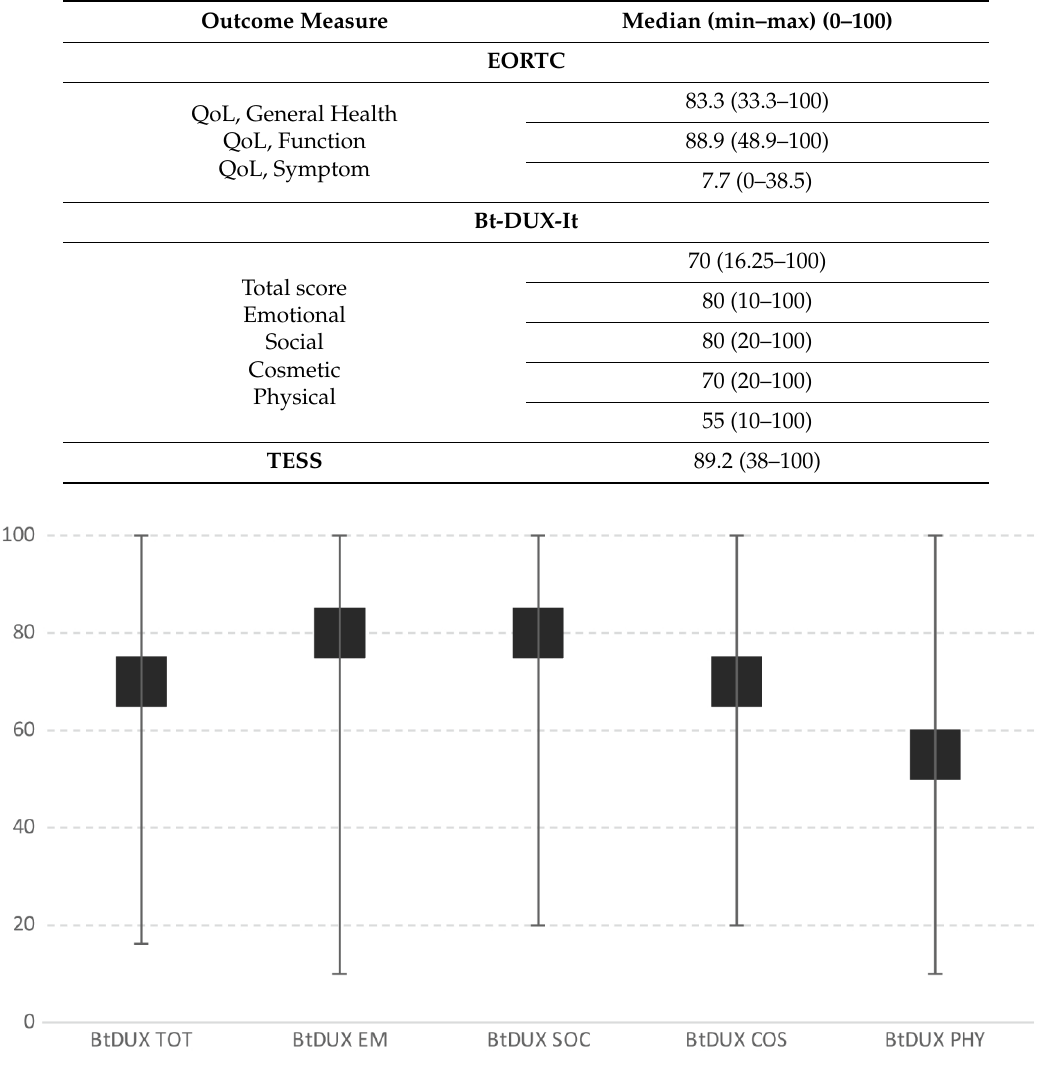
Table 3. Spearman correlation coefficients between the total Bt-DUX-It, Bone tumour Dux Italian version, scores and EORTC and functional ability. QLQ, Quality of Life Questionnaire. Bt-DUX-It